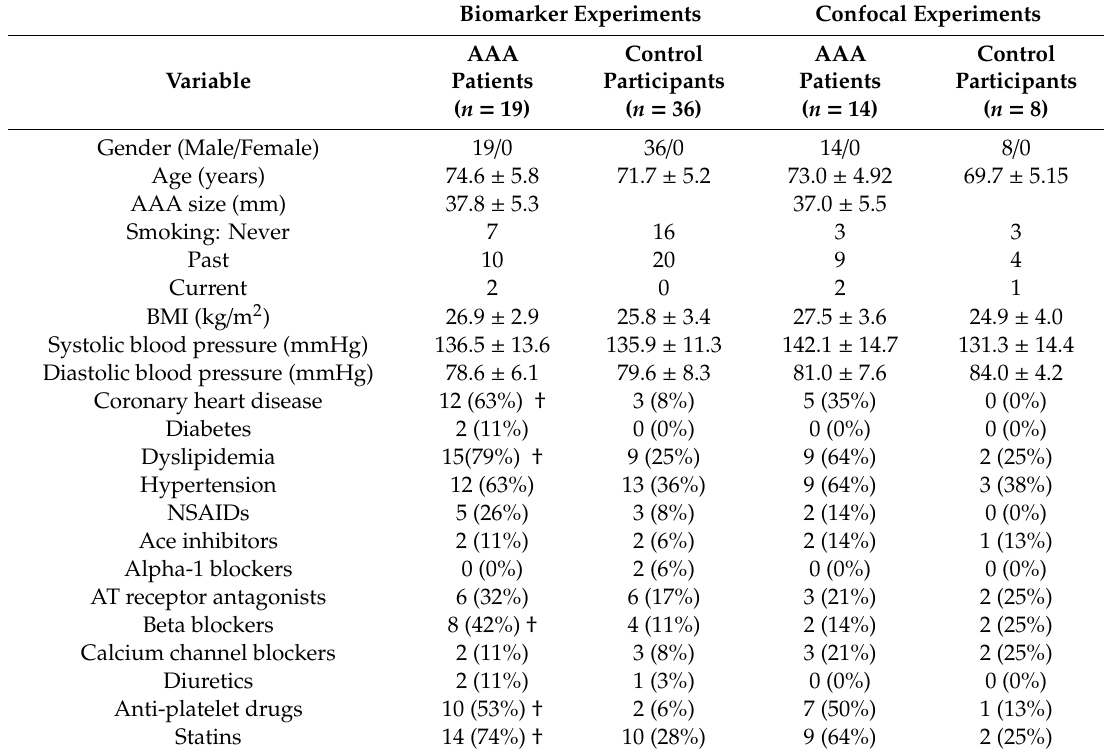
Table 1. Demographic, biometric and medical characteristics of abdominal aortic aneurysm (AAA) patients and control participants. Continuous demographic data are presented as mean ± SD, categorical demographic data are presented as number